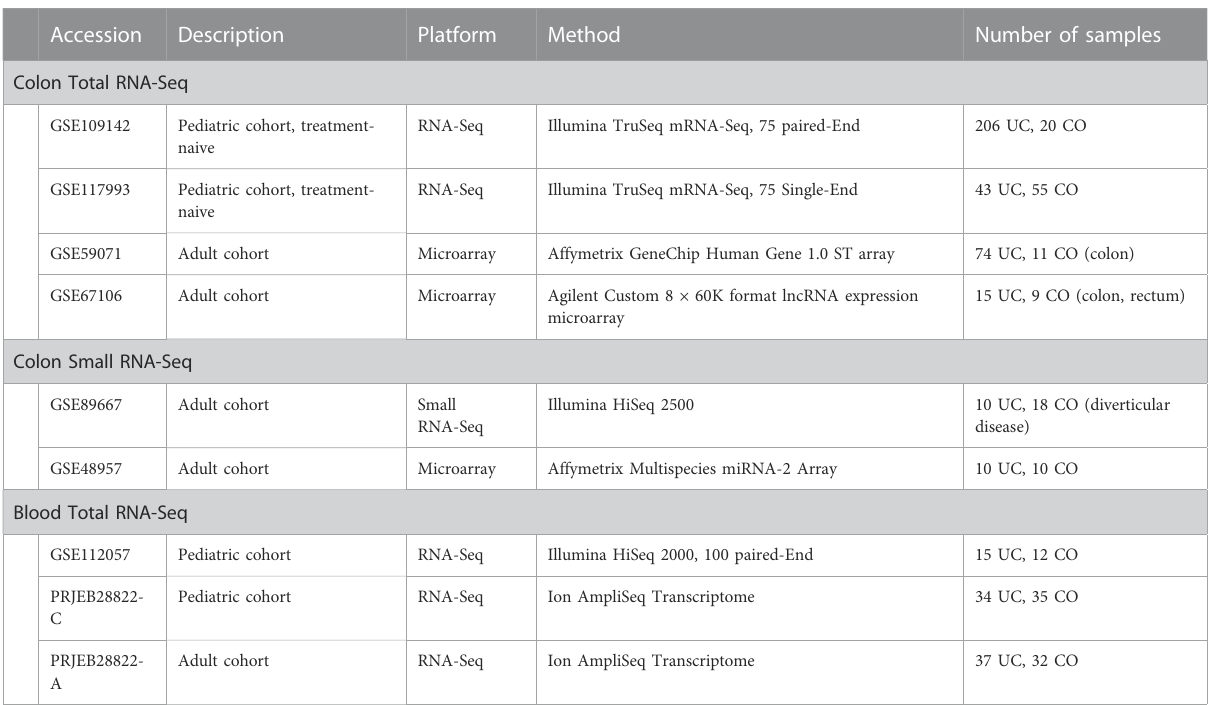
TABLE 2 Public human UC datasets used in our